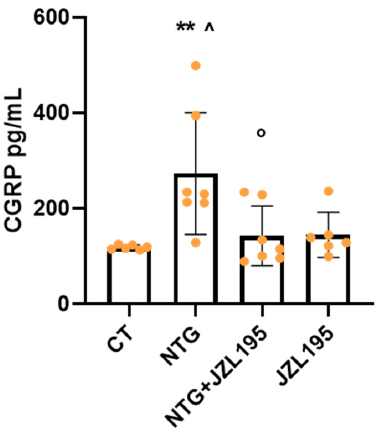
Figure 7. CGRP serum levels (pg/mL). Male Sprague–Dawley rats were treated with JZL195 at a dose of 3 mg/kg (i.p.) dissolved in a volume of 2 mL/kg of vehicle (Tween-80/polyethylene glycol 200/saline). Rats underwent the orofacial formalin test 4 h after NTG and vehicle injection. All animals were sacrificed at the end of the formalin test and blood collected evaluate CGRP serum levels. Data are expressed as mean ± SD. One-way ANOVA followed by Tukey’s multiple comparisons test; ** p < 0.01 vs. CT; ˆ p < 0.05 vs. JZL195; ◦ p < 0.05 vs. NTG. CT: control group ( n = 6); NTG: nitroglycerin group ( n = 7); NTG + JZL195: nitroglycerin + JZL195 group ( n = 7); JZL195: nitroglycerin vehicle + JZL195 group ( n =